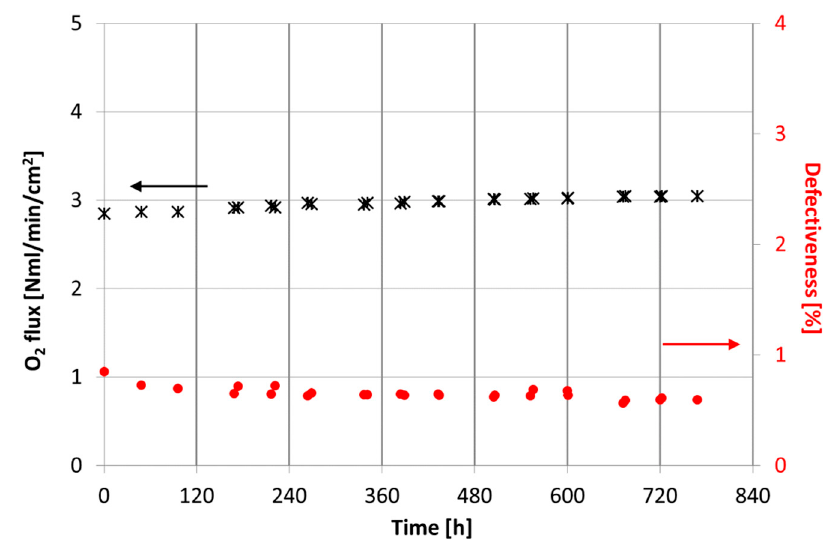
Figure 11. Long-term test results in terms of oxygen flux and defectiveness over time. Tests performed on sample M2 by feeding air as process gas and 100 Nml/min of helium as sweep gas.